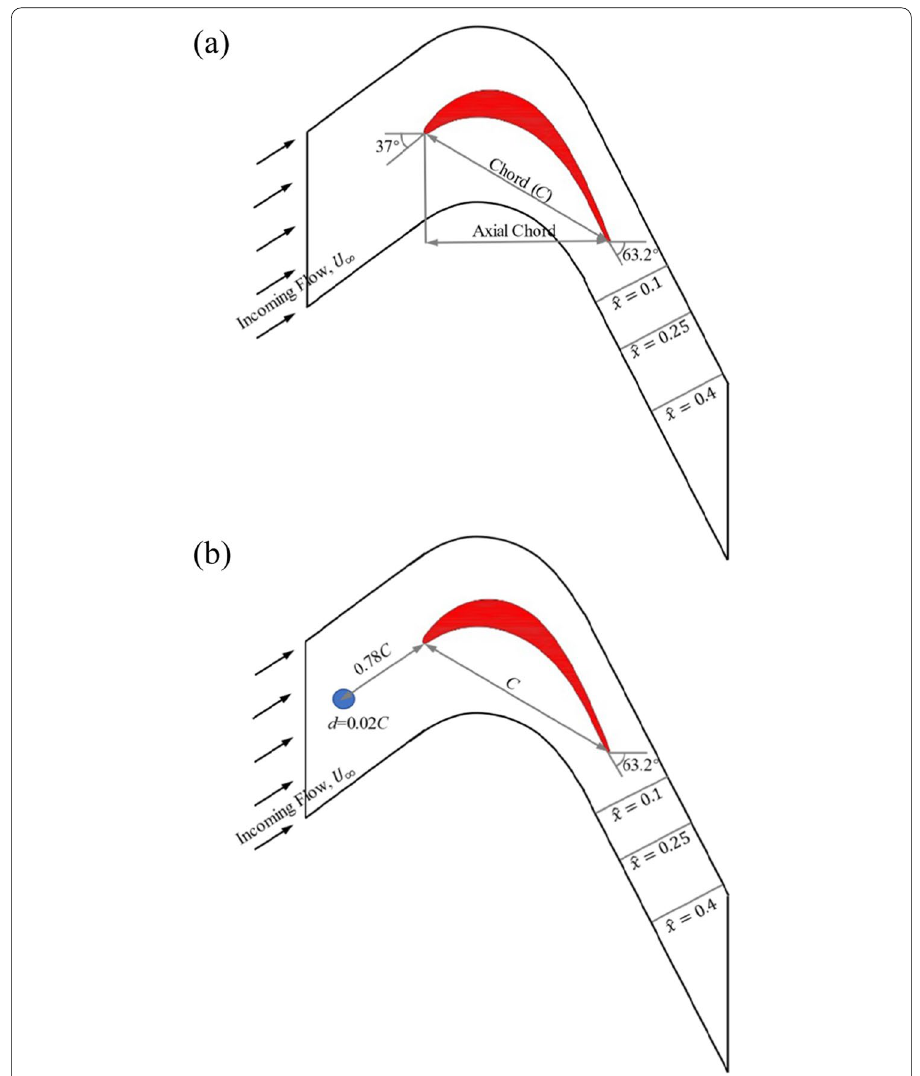
Fig. 1 Schematic diagram of T106A LPT cascade: ( a ) Case I under uniform inflow condition and ( b ) Case II under incoming disturbed inflow